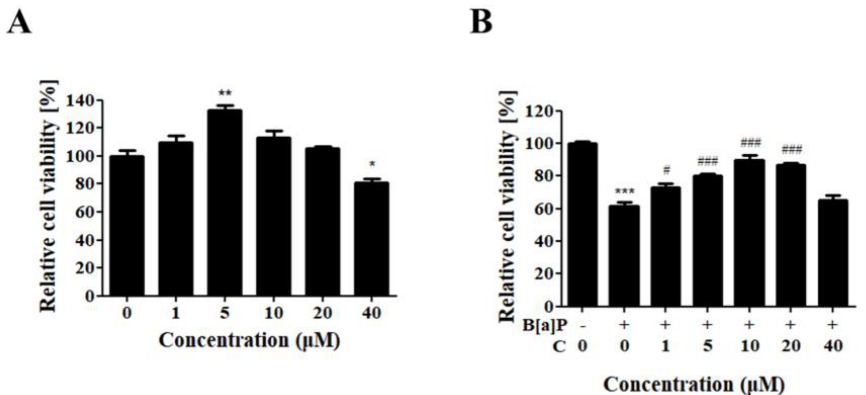
Figure 1. Protective effect of curcumin against B[a]P-induced cytotoxicity. ( A ) Relative viability of HepG2 cells treated with curcumin. N = 3 trials per sample and control. ( B ) Ameliorative effect of curcumin on B[a]-induced cytotoxicity in HepG2 cells. N = 3 trials per sample and control. * p < 0.05, ** p < 0.01, and *** p < 0.001, compared with the nontreated group; # p < 0.05 and ### p < 0.001, compared with the B[a]P-treated group; # p < 0.05 and ### p < 0.001, compared with B[a]P-treated cells. B[a]P: benzo[a]pyrene (10 µM); C: curcumin (1, 5, 10, 20, 40 µM).